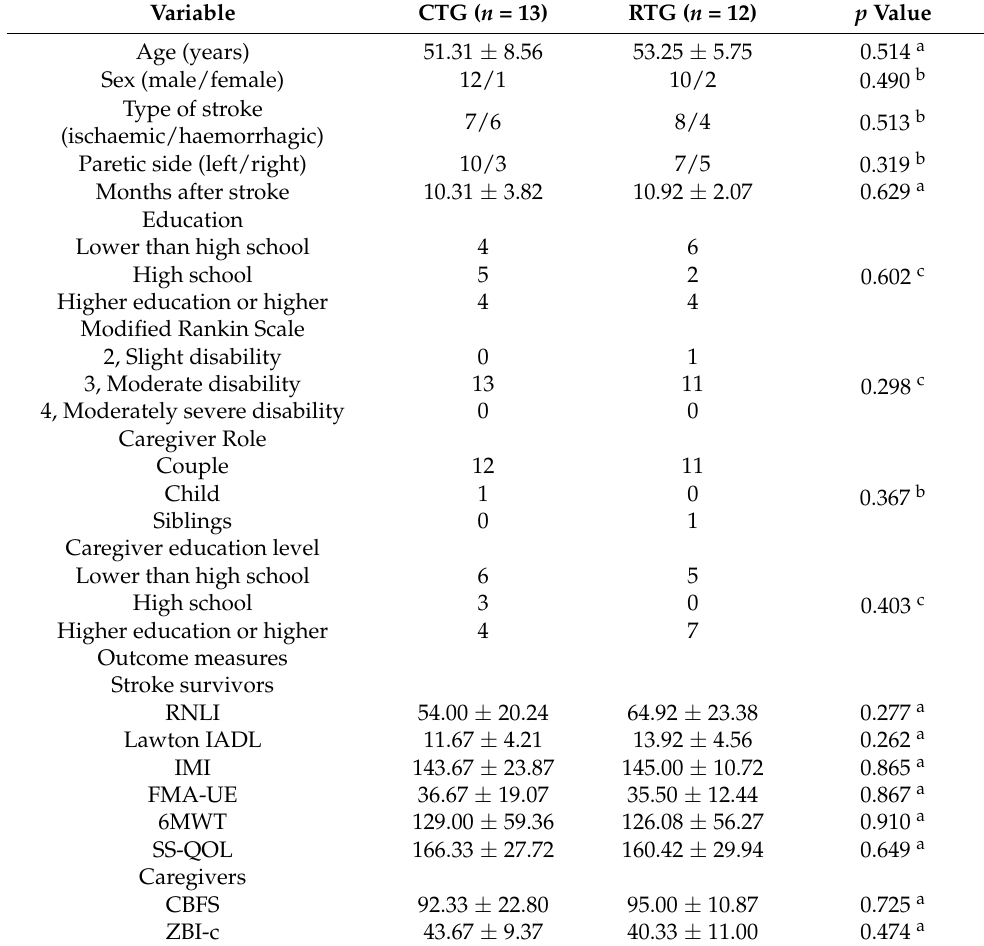
Table 1. Basic characteristics and effectiveness outcome measures for stroke survivors and